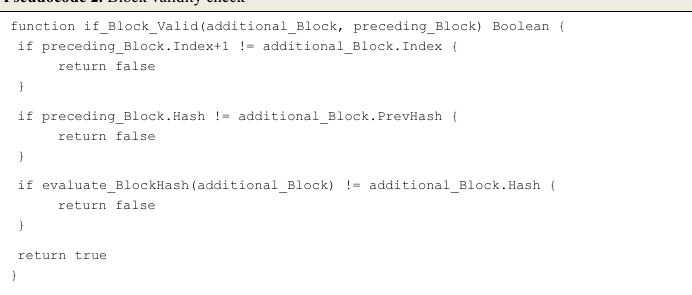
Pseudocode 2. Block validity